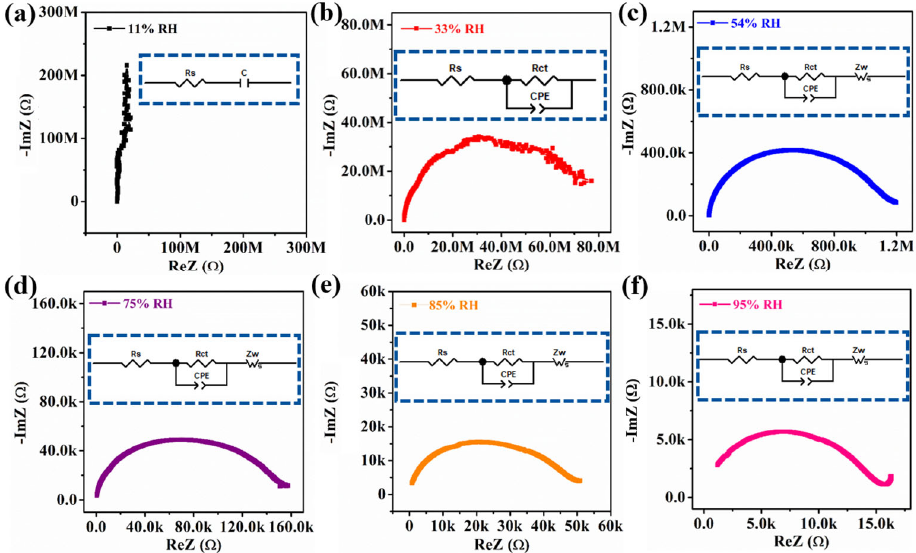
Figure 6. The complex impedance spectroscopy plots and corresponding circuit diagrams of CIL@Cl − 2 sensor in ( a ) 11% RH, ( b ) 33% RH, ( c ) 54% RH, ( d ) 75% RH, ( e ) 85% RH and ( f ) 95% RH.